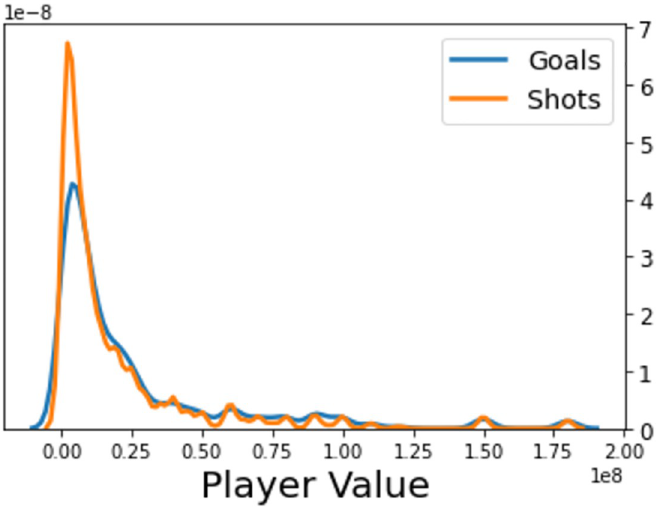
Fig 6. Kernel density estimate of the player